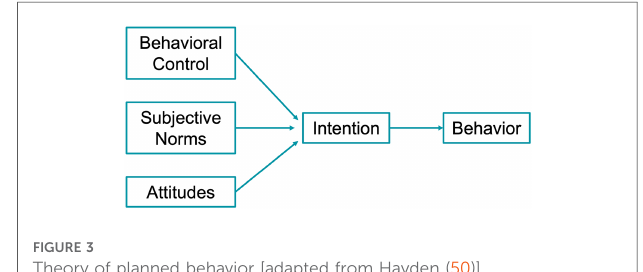
FIGURE 3 Theory of planned behavior [adapted from Hayden